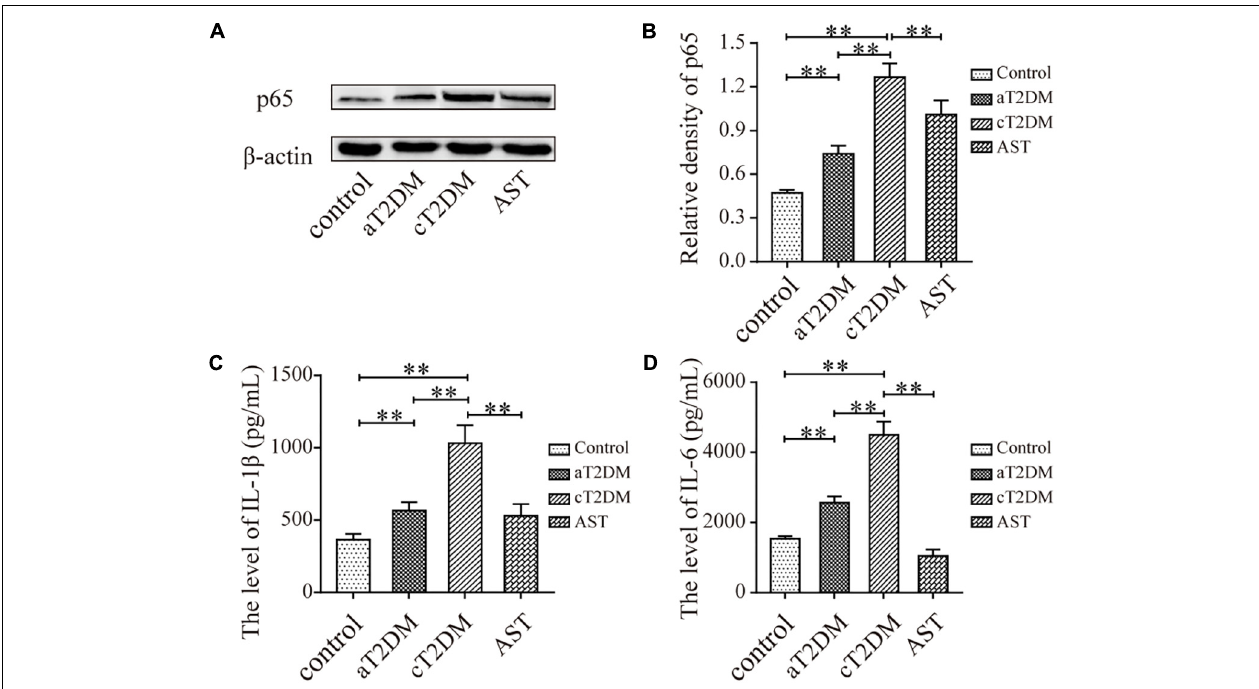
FIGURE 5 | The expression levels of NF-kB p65, IL-1 β , and IL-6 in each group. Immunoblots (A) and histogram (B) showing the expression of NF-kB p65. The levels of IL-6 (C) and IL-1 β (D) are also displayed in the histogram. Data are shown as the mean ± SD. ∗∗ P < 0.01. aT2DM, acute type 2 diabetes mellitus; cT2DM, chronic type 2 diabetes mellitus; AST, astaxanthin.